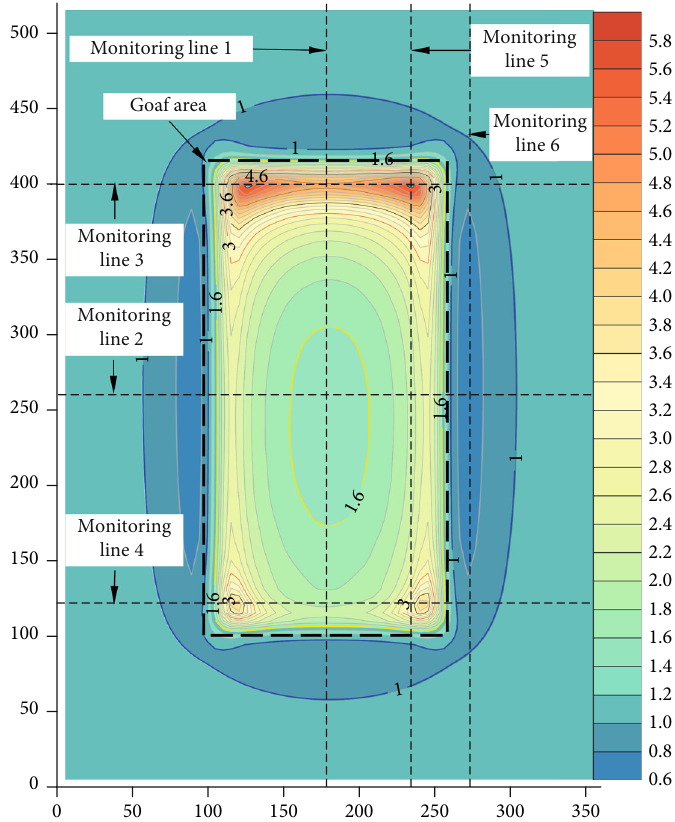
Figure 8: Bidirectional stress ratio distribution at 13m below the fl